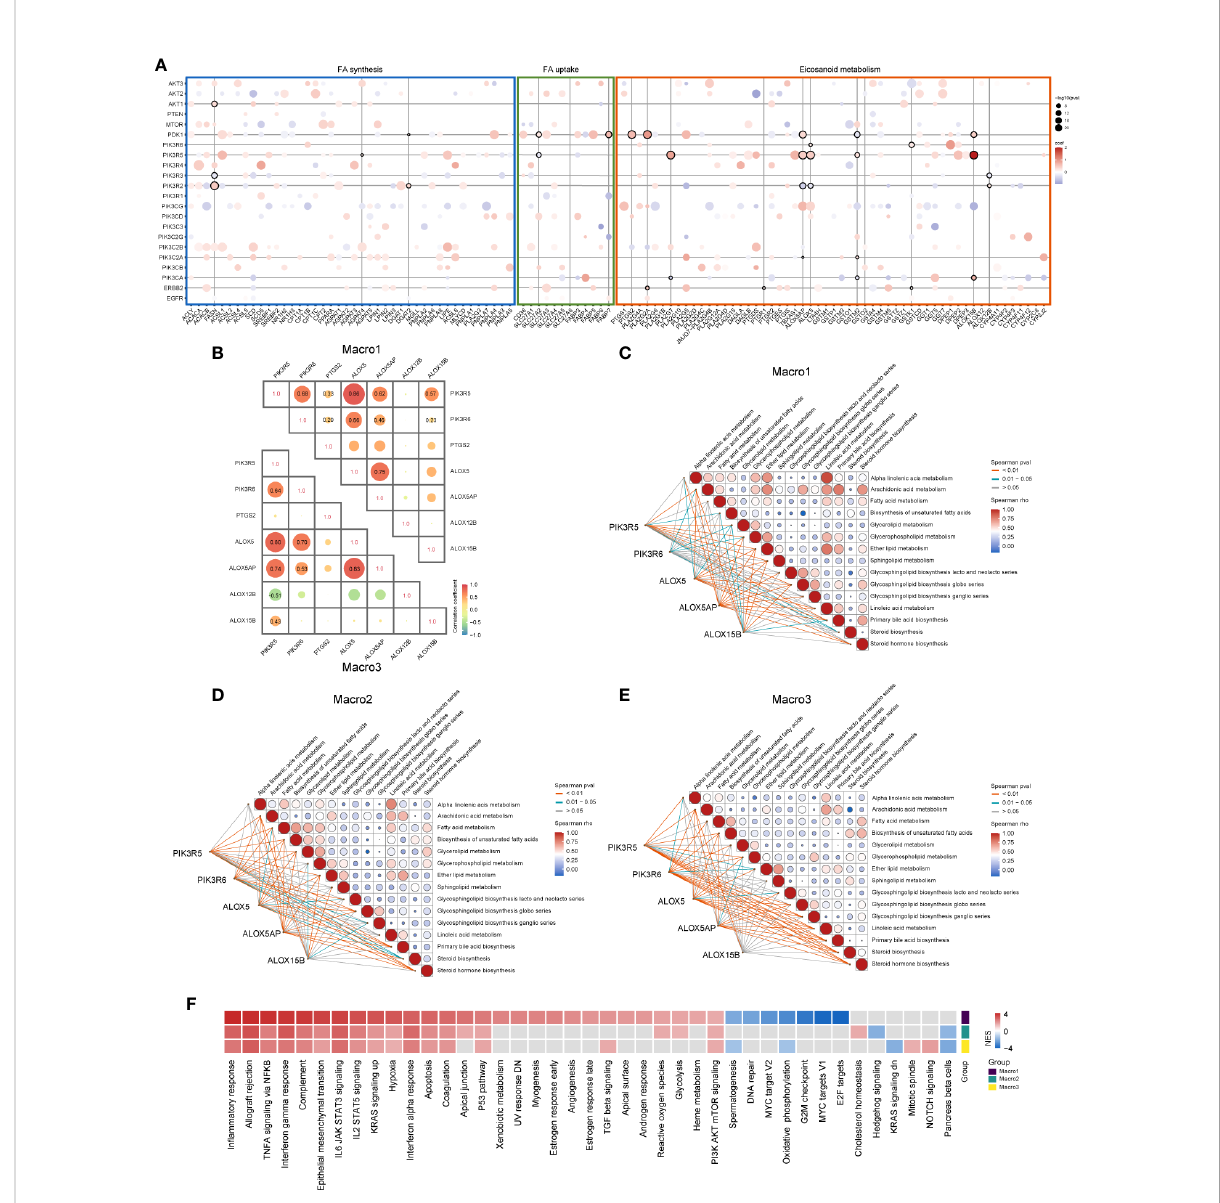
FIGURE 3 Association of PI3K signaling pathway members with FA metabolic genes that signi fi cantly correlated with M2 fraction. (A) The correlation between PI3K pathway members and FA metabolic genes was evaluated using a multivariate regression model at the signi fi cance level of p < 0.0001. Bubbles indicate that the regression coef fi cients of the two are signi fi cant, red indicates positive regression coef fi cients and blue negative. Horizontal or vertical lines mark PI3K members or FA metabolic genes that are signi fi cantly correlated with the M2 fraction. (B) Spearman correlation analysis of candidate genes that were likely to form a gene network. (C-E) Correlation of PIK3R5/6, ALOX5/5AP/15B, and KEGG lipid metabolism-related signaling pathways in each group. (F) GSEA analysis determines signaling pathways that affect the M2- related gene network based on the HALLMARK gene sets. The input pre-ranked gene list is a ranked list of genes determined by the Spearman rho of all human genes with the Macro